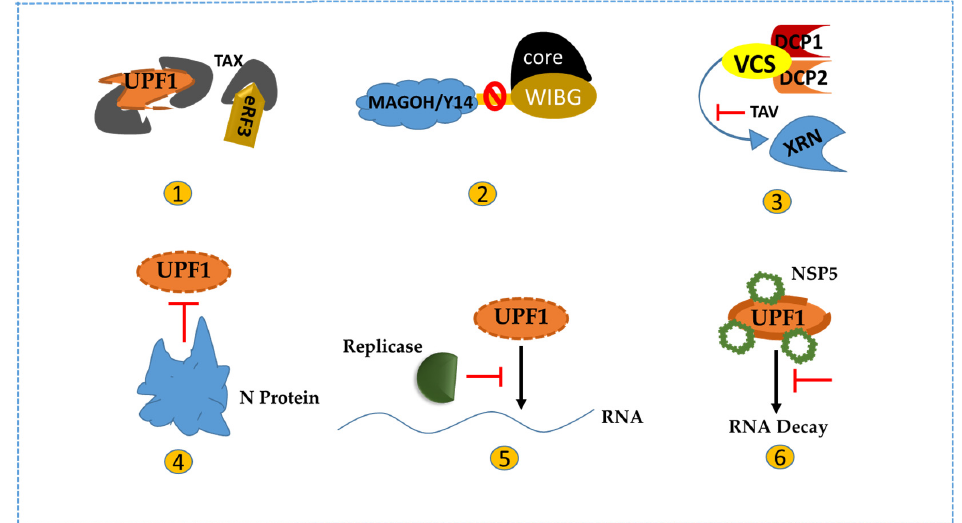
Figure 3. Viral protein-based strategies to modulate NMD activity: ( 1 ) Retroviral Tax factor antagonizes NMD by binding with eRF3 and UPF1 to prevent the SURF complex formation. By binding with UPF1, Tax disrupts its translocation and binding affinity to nucleic acids and other proteins; ( 2 ) HCV-Core Protein disrupts NMD by binding with host protein WIBG to block the recycling interaction between WIBG and MAGOH/Y14; ( 3 ) Trans-acting activator (TAV) of CaMV interrupts decapping by interacting with VCS and subsequent decay of decapped transcript by the XRN complex; ( 4 ) Coronavirus N-protein binds to UPF1 and diminishes its activity for NMD; ( 5 ) SFV replicase protein dislocates UPF1 from viral RNA to modulate host NMD response; ( 6 ) Non-structural protein (NSP5) promotes UPF1 degradation during rotavirus infection to inhibit the RNA decay pathway.